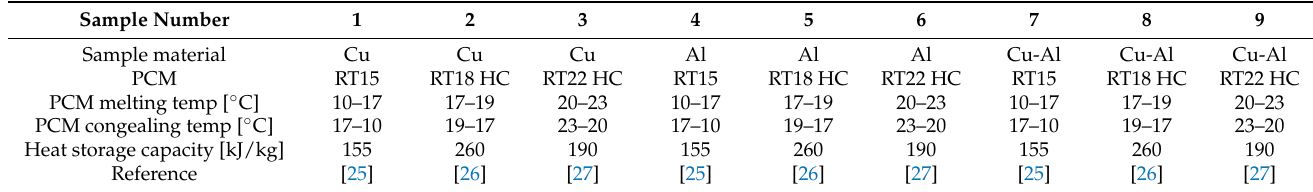
Table 2. Distribution of metal samples in tubes with